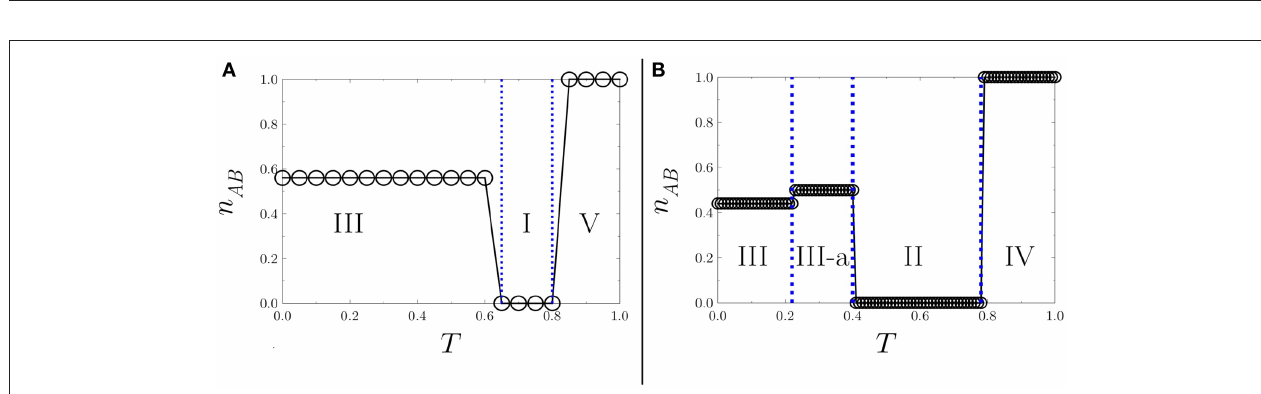
FIGURE 7 | (A): Bifurcation diagram among solutions III, I, and V of the average of n AB as function of T in the SCG for a fixed initial condition x aa = 0.20 and x bb = 0.60. (B): Bifurcation diagram among solutions III, III-a, II, and IV of the average of n AB as function of T for a fixed initial condition x aa = 0.78 and x bb = 0.60 where the risk parameter b = 3 in the